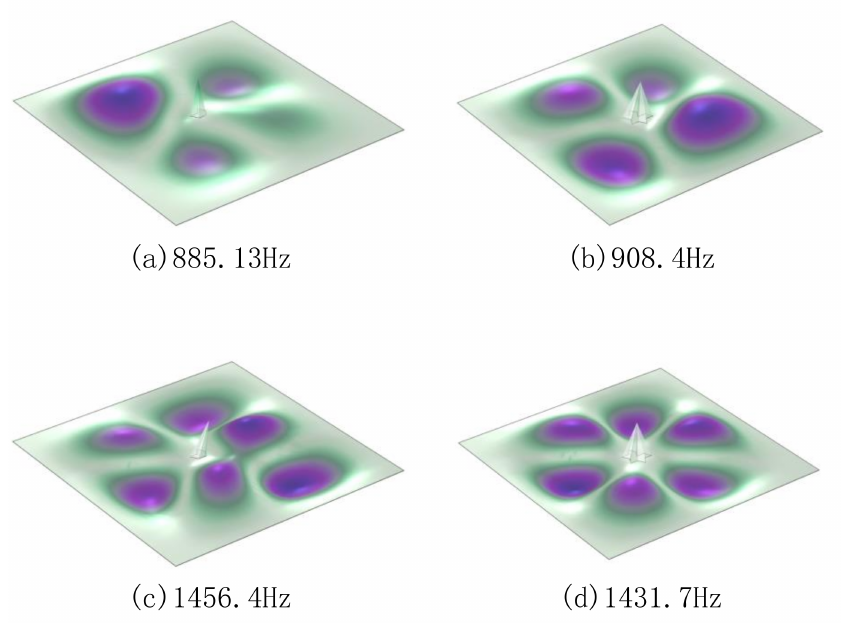
Figure 10. Modes of some membrane-type metamaterials: ( a ) the modal of D2, which existed near the STL curve valley of D5; ( b ) the modal of D5, which existed at the STL curve valley; ( c ) the modal of D2, which was near the STL peak value of D5; ( d ) the modal of D5, which existed in the mode of STL peak.